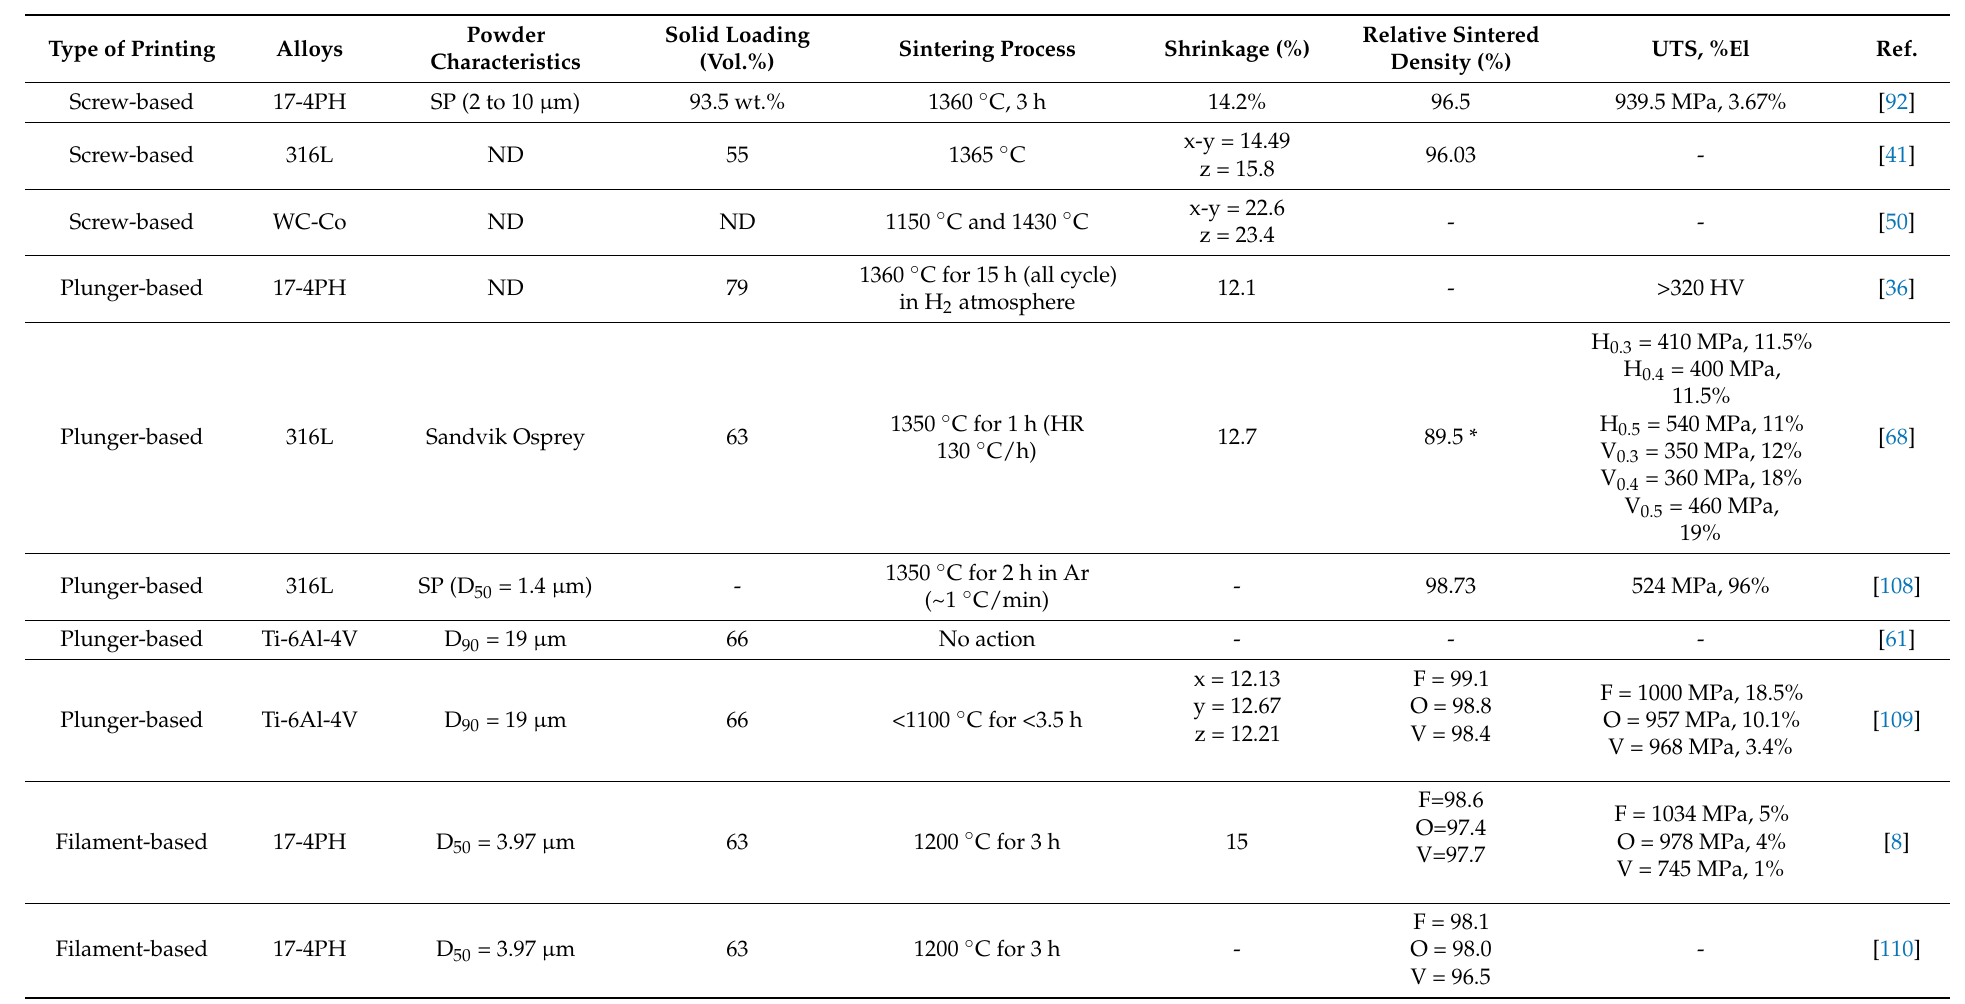
Table 6. Effects of sintering temperature on shrinkage density and mechanical properties (ND is no detail; SP is spherical powder; IP is irregular powder) * The value was converted from density to relative sintered density for